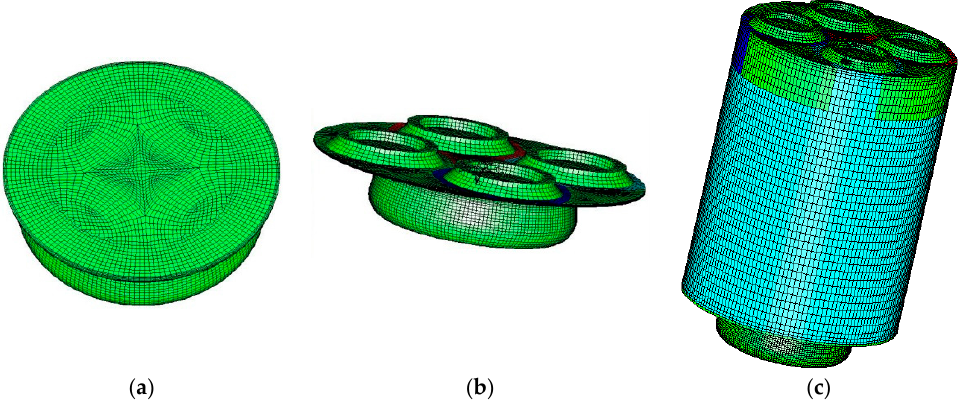
Figure 1. Simulation model of six-cylinder diesel engine, ( a ) O-grid combustion chamber; ( b ) simulation model at top dead center (TDC); ( c ) simulation model at bottom dead center (BDC).